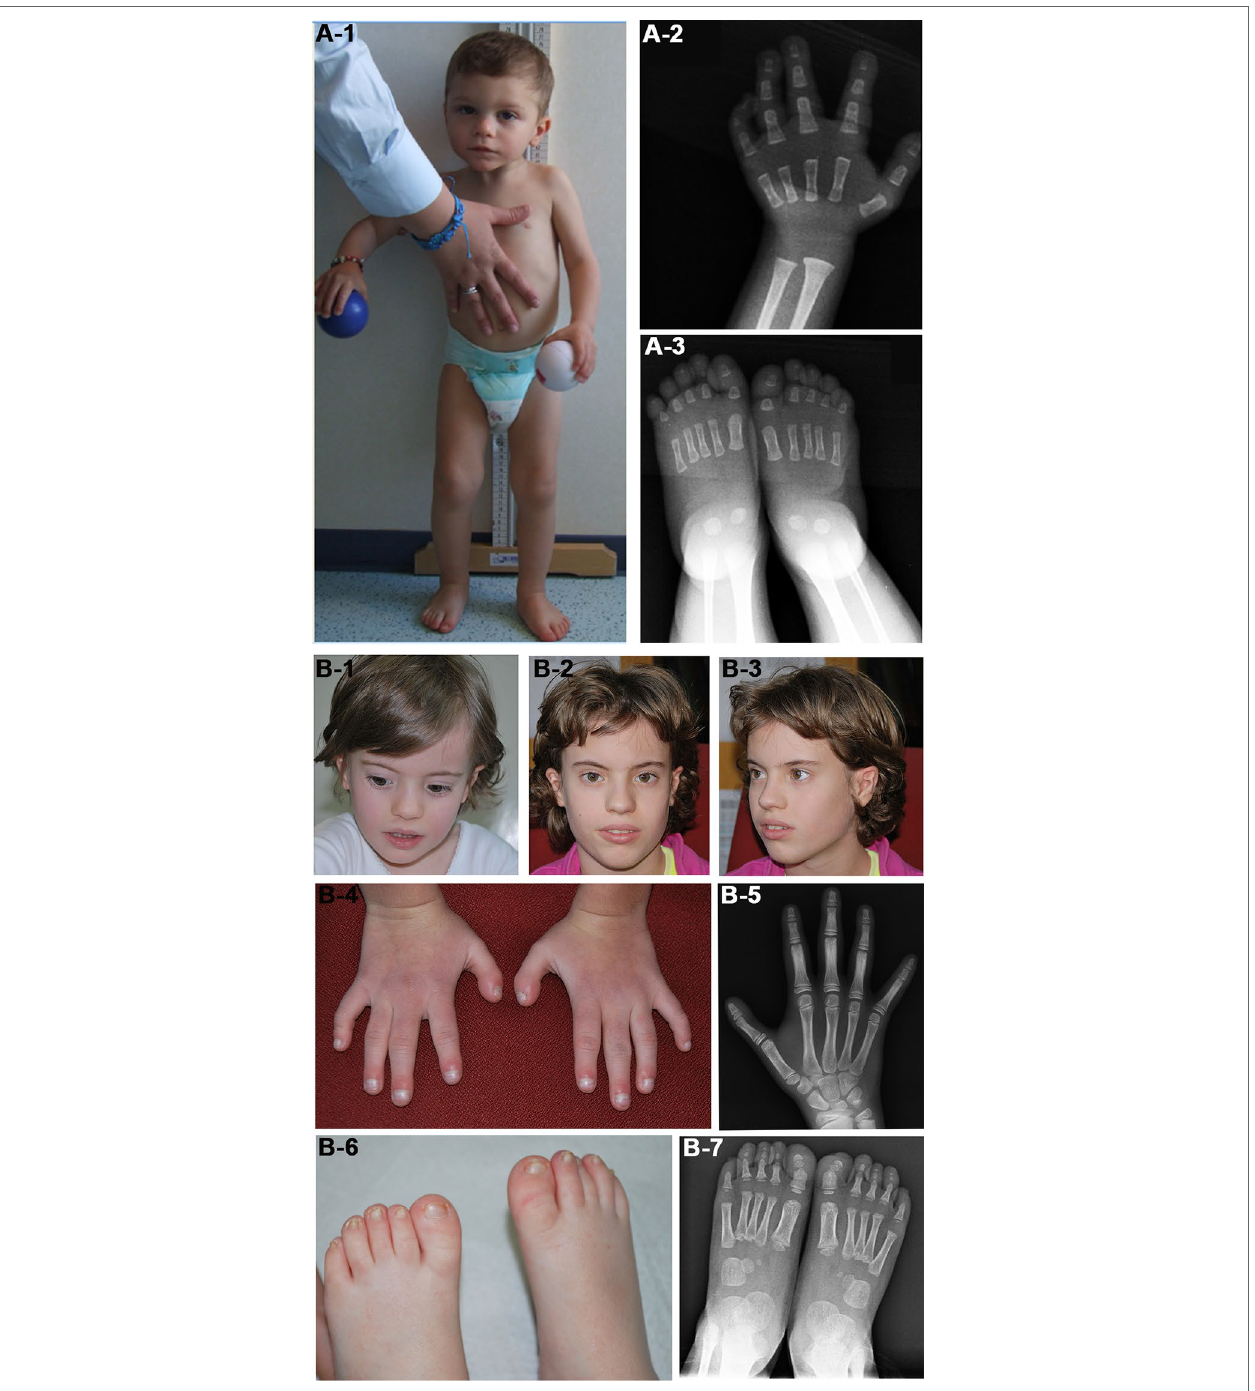
FIGURE 2 | Photographs of patients 7 (A) and 20 (B). (A-1) Face and whole body of patient 7 at 28 months showing proportionate short stature, mild craniofacial dysmorphisms, that is, triangular face and slight micrognathia, and flat feet. (A-2 and 3) Left hand and feet X-rays of the patient at 11 months showing (A-2) absence of the carpal bone nuclei, suggestive of a delayed bone age, fifth finger clinodactyly with hypoplastic and triangular shaped intermediate phalanx and distal phalanx hypoplasia, and (A-3) short first toes. The absence of bone nuclei at the carpus (A-2) and their presence at the tarsus (A-3) suggest a non-uniform pattern of skeletal maturation. (B-1, B-2, and B-3) Facial appearance of patient 20 at 4 years (B-1) and 10 years (B-2, B-3) showing prominent forehead and triangular face more evident in childhood. (B-4) Small hands with proximal placement and ulnar side bowing of first fingers, and clinodactyly of fifth fingers. (B-5) Left hand X-rays of the patient at 10 years showing hypoplasia of distal phalanges. (B-6) Small feet with short and broad halluces, right over-riding toes, and small/deep-set nails. (B-7) Feet X-rays of the patient at 4 years showing proximal placement of fifth metatarsals, absence of distal phalanges in second and fifth toes, absence of middle phalanges in fifth toes, and phalanges